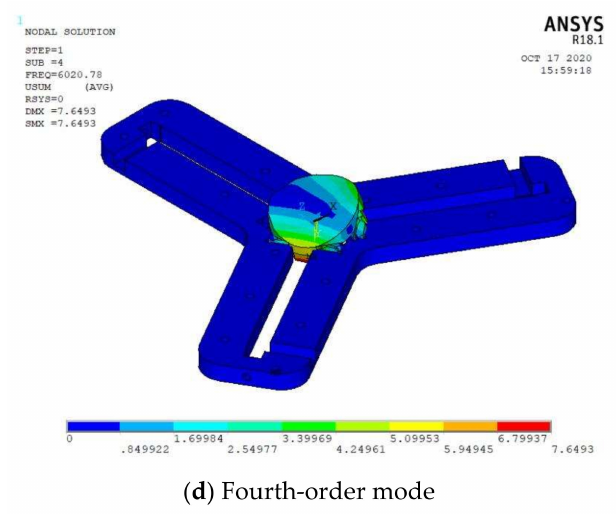
Figure 5. Modal analysis.